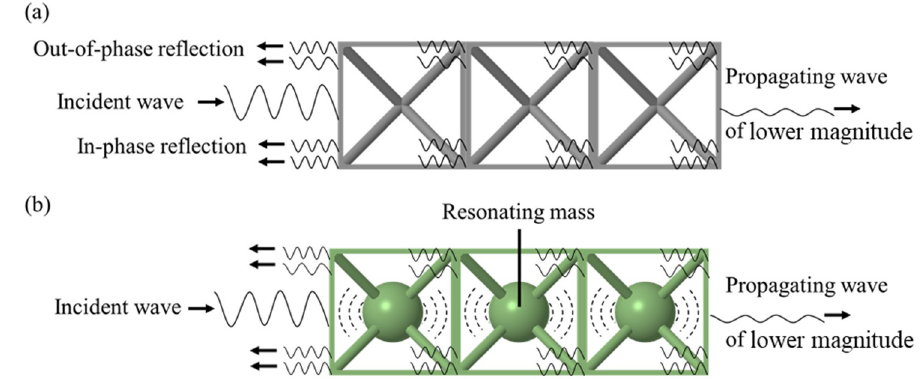
Figure 1. Illustration of the bandgap mechanism in ( a ) Bragg-scattering lattices and ( b ) internal resonance lattices.